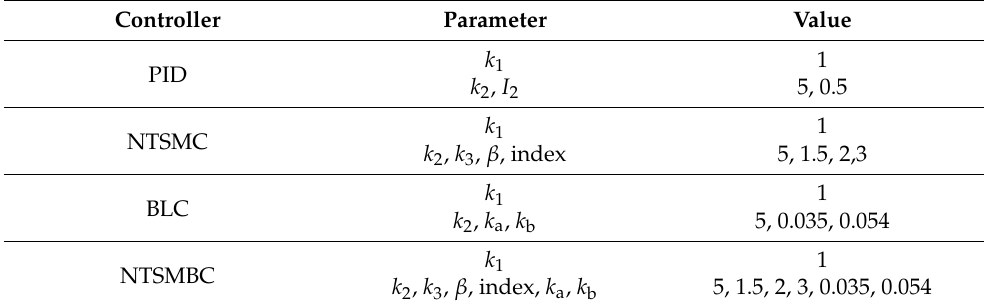
Table 2. Parameters of the pitch angle controllers.